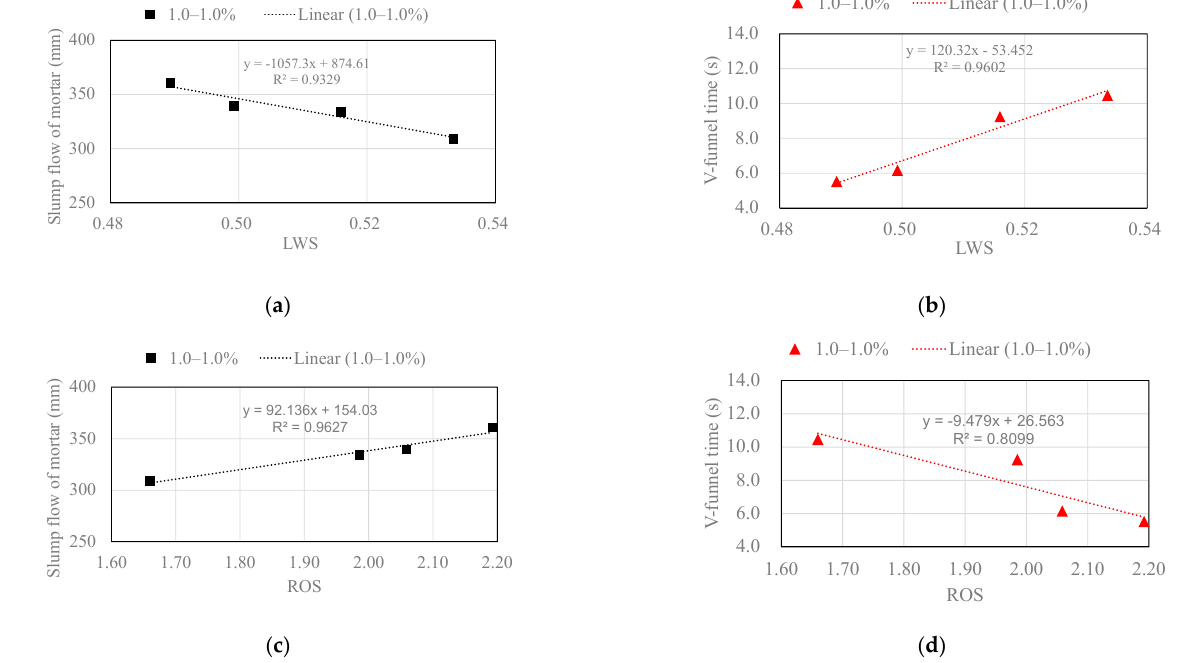
Figure 8. Relationship between rheological properties and shape–weight parameters: ( a ) SF vs. LWS , ( b ) V-funnel time vs. LWS , ( c ) SF vs. ROS , ( d ) V-funnel time vs. ROS .